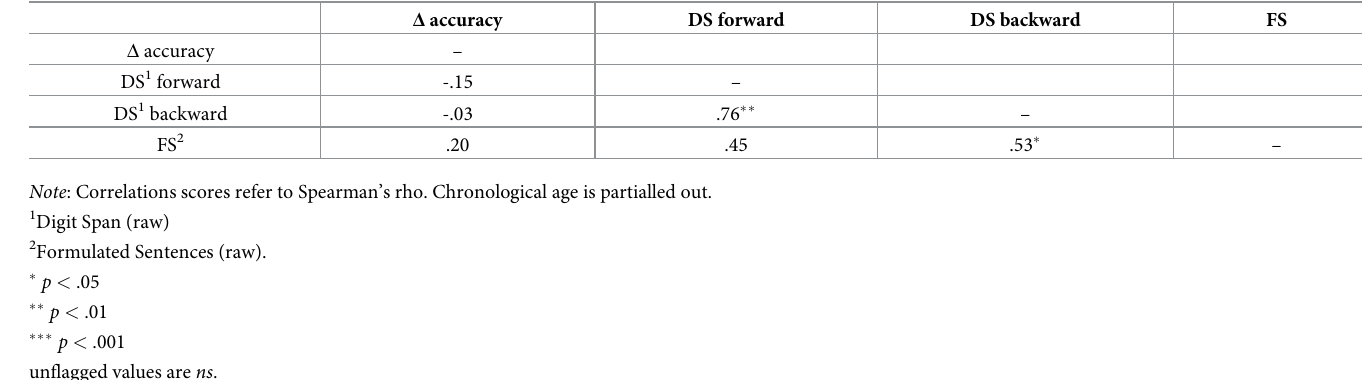
Table 7. Tasks scores partial correlations for the deaf